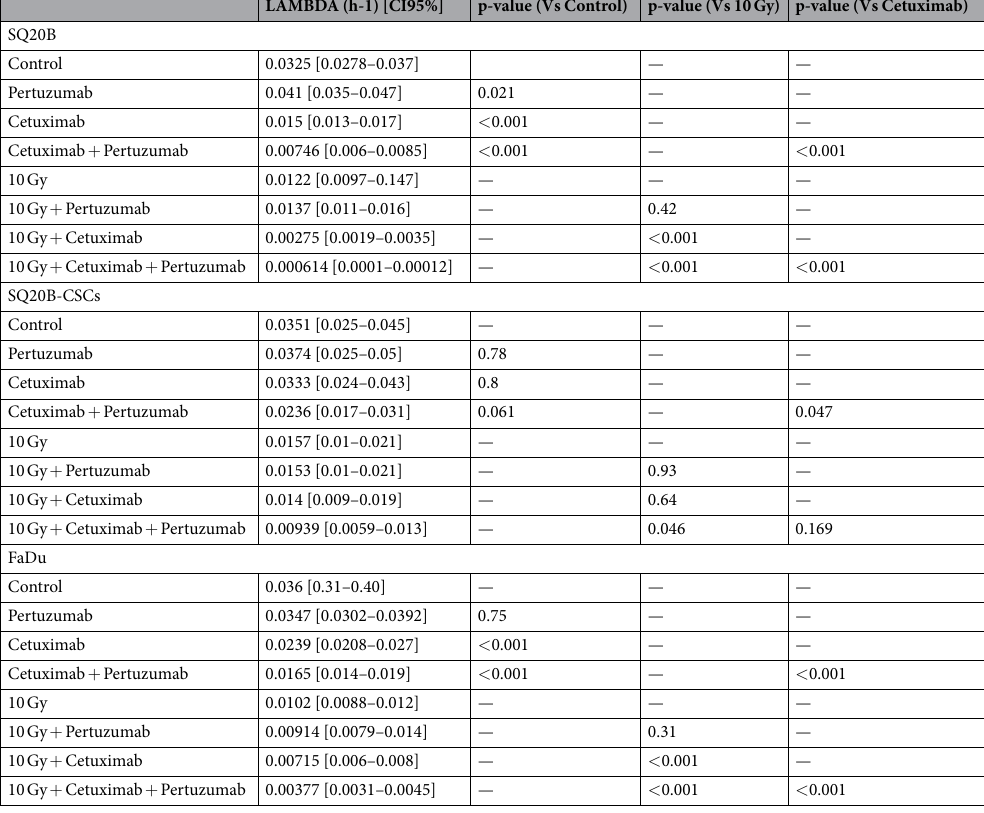
Table 1. Cell proliferation expressed by cell growth rate per hour (Lambda (h-1)) and p-values. Leg. Lambda (h-1): cell growth rate per hour; CI95%: confidence interval; Vs: versus; Gy: Gray